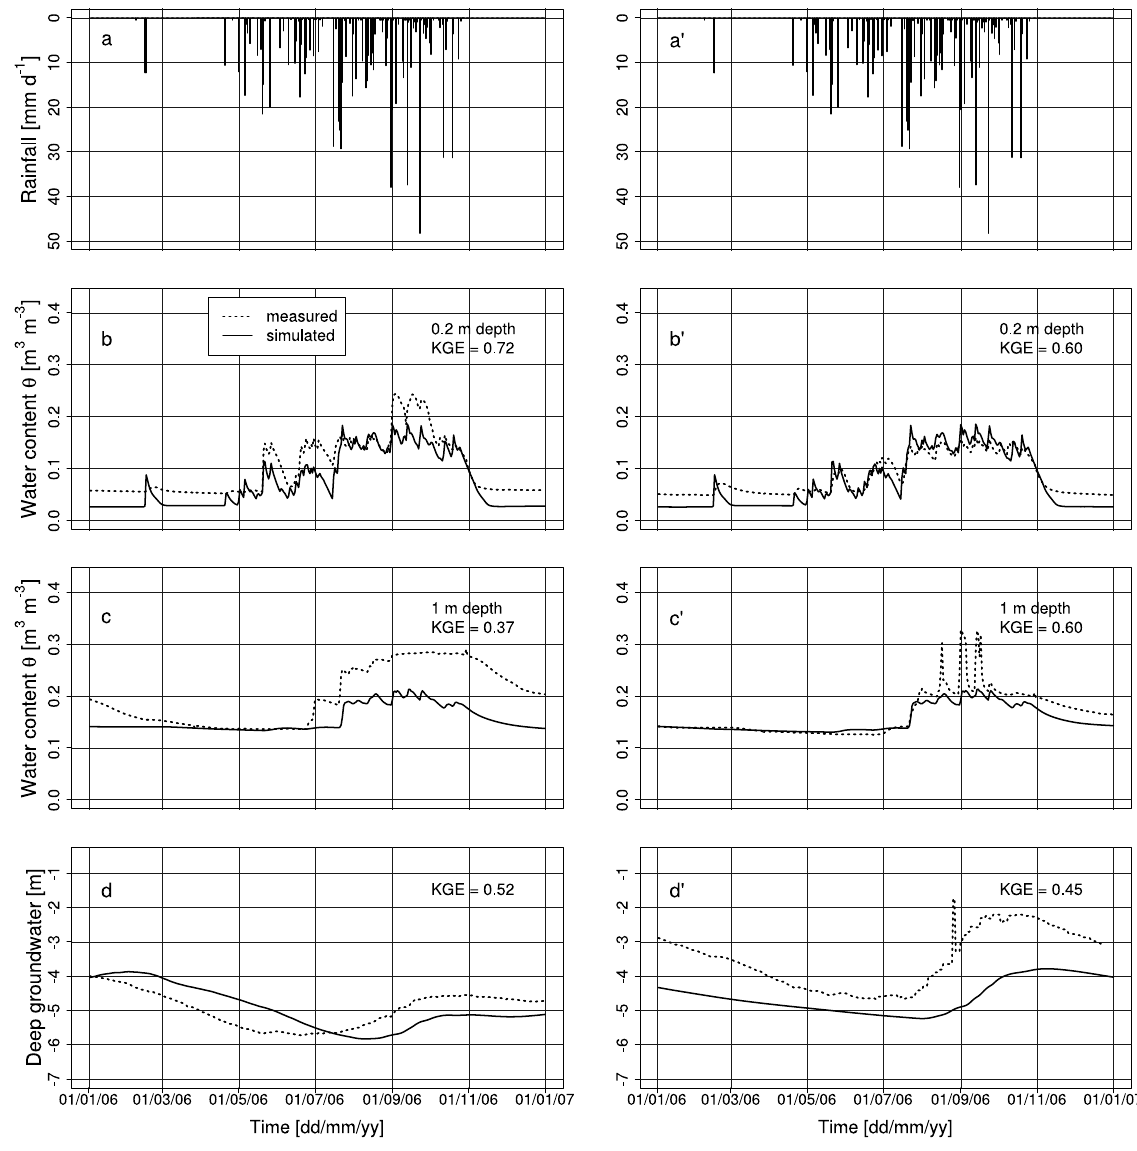
Fig. 5. Forcing variable (rainfall) and state variables of Hydrus 2-D for the 2006 simulation. Graphs on the left are for the bottom of the hillslope; graphs on the right are for the middle of the hillslope. (a, a’) measured rainfall; (b, b’) measured and simulated water content at 0.2m depth; (c, c’) measured and simulated water content at 1m depth; (d, d’) measured and simulated groundwater table